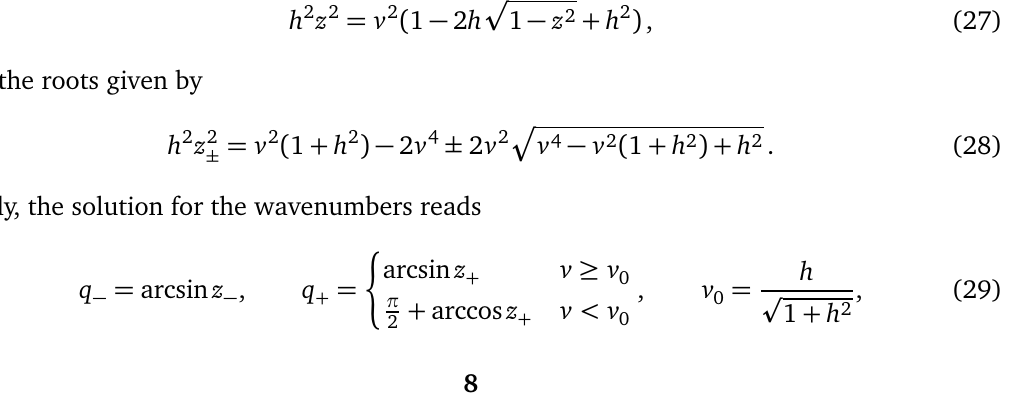
Figure 2: Left: graphical solution of the equation v a function of v